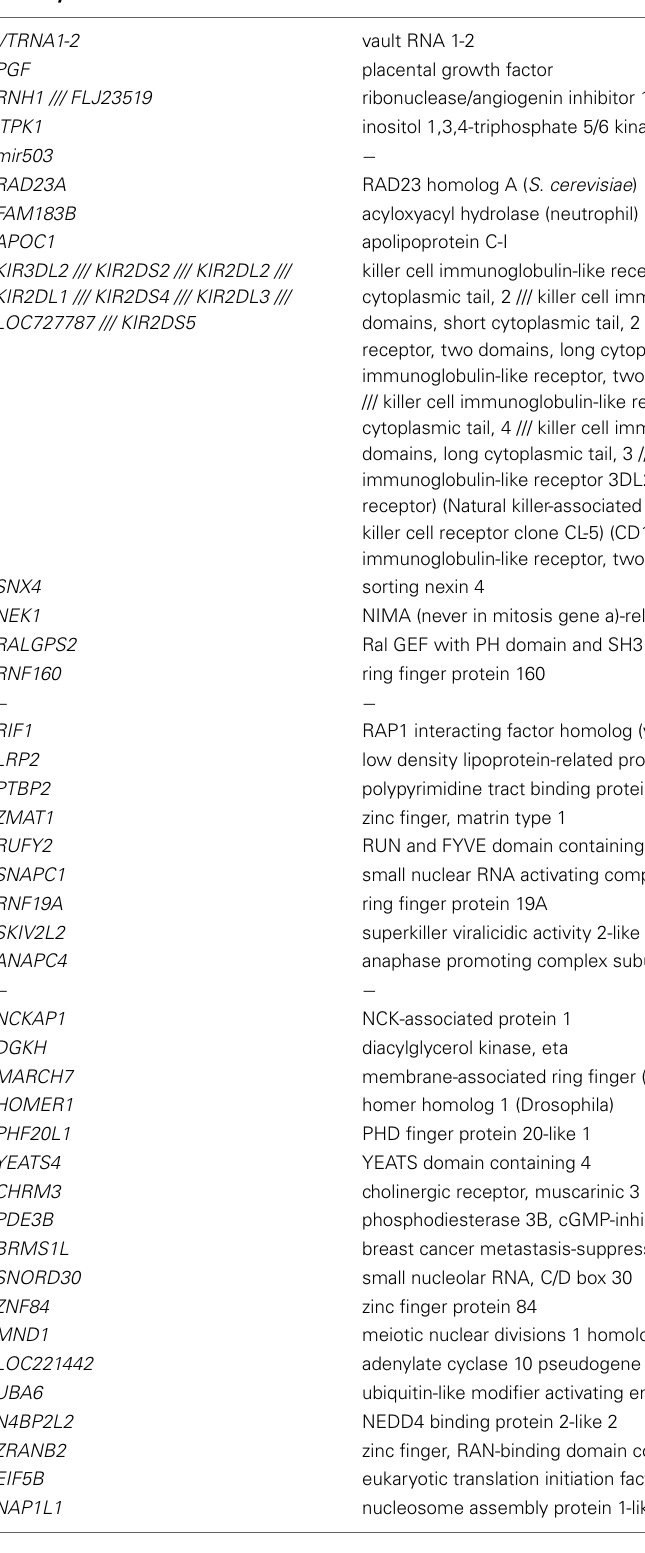
Table 3 | Significantly up and down regulated genes in the control vs. depressed groups ( − = reduction in expression levels). Gene